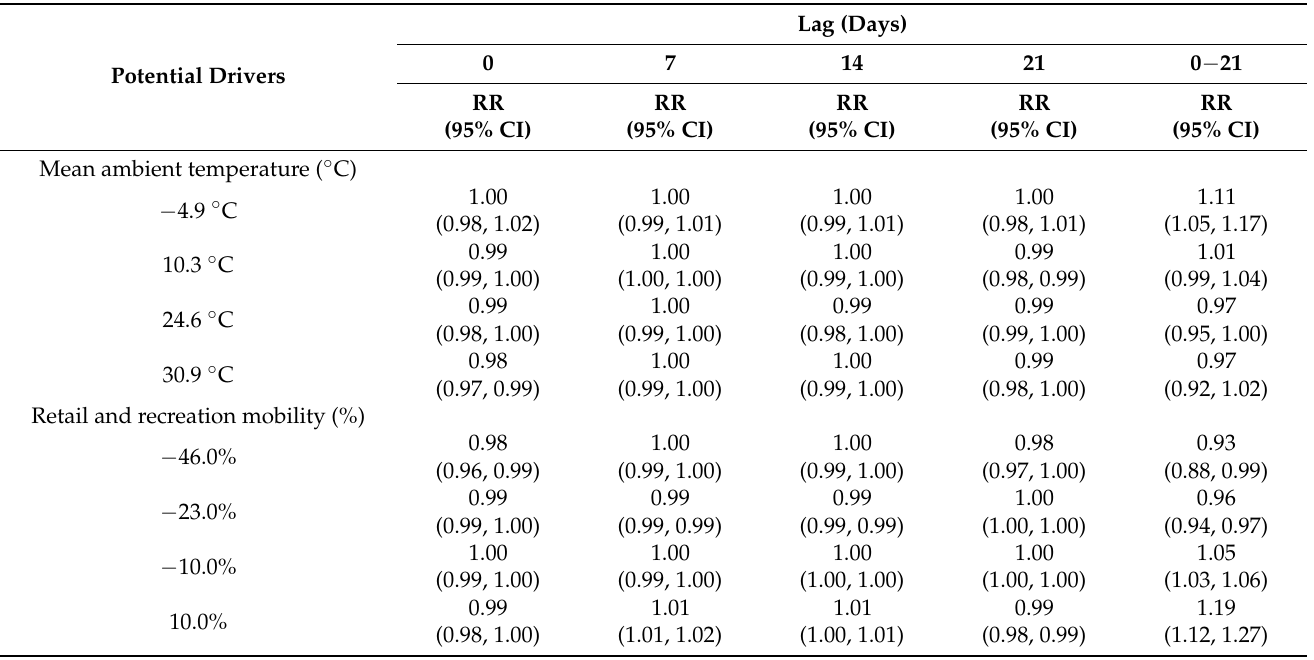
Table 2. Assessing the specific relative risks of non-linear and delayed associations between the time-dependent transmissibility of SARS-CoV-2 and mean ambient temperature and retail and recreation